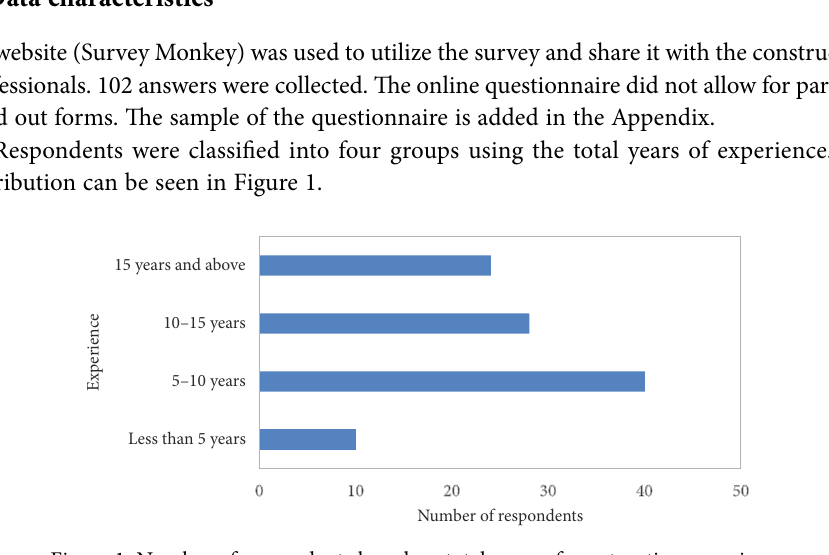
Figure 1. Number of respondents based on total years of construction